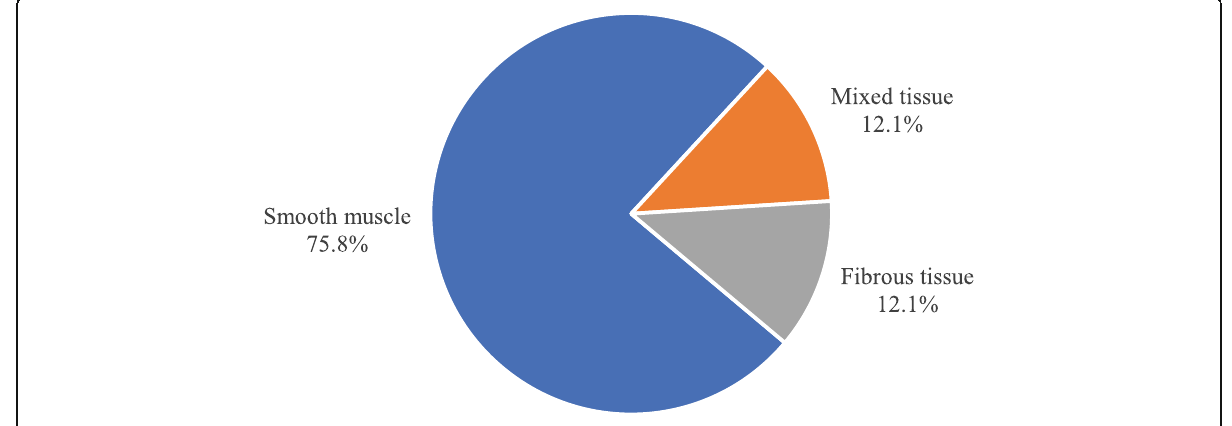
Fig. 4 Pie chart depicting histopathological findings in all patients operated